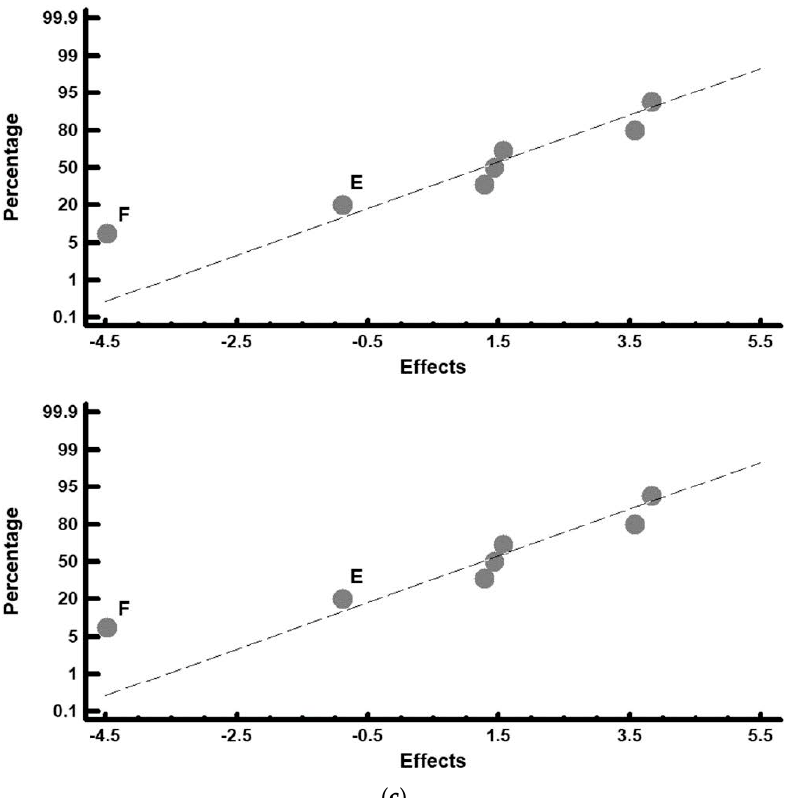
Figure 3. Representation of the effects on a normal probability plot. Those factors with a significant effect on the analyzed responses are highlighted. ( a ) overall hardness; ( b ) hardness of the matrix phase; ( c ) weight loss in the erosive wear test (mm 3 /g × 10 6 ). Table 5. Analysis of the effects of interactions AE and BF on the hardness of the material.